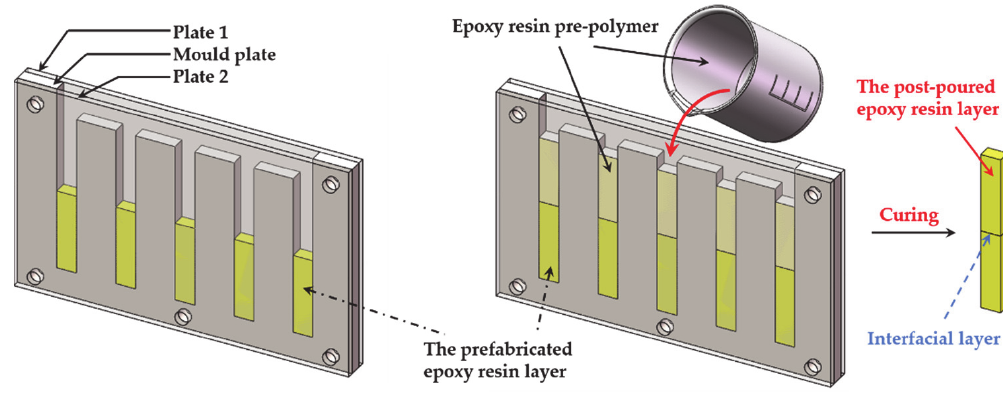
Figure 4. The preparation process of the mechanical samples.